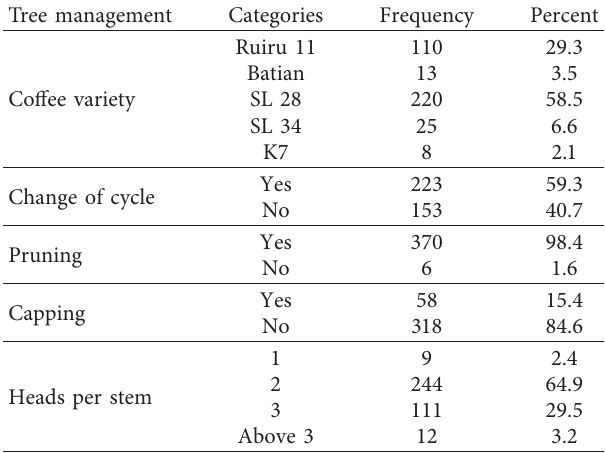
Table 4: Descriptive statistics of coffee management practices among